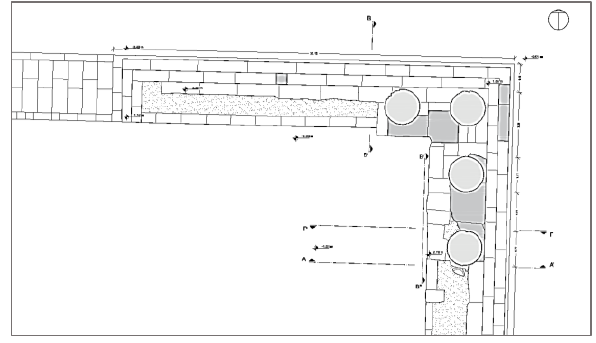
Figure 4: Excerpt of horizontal section drawing